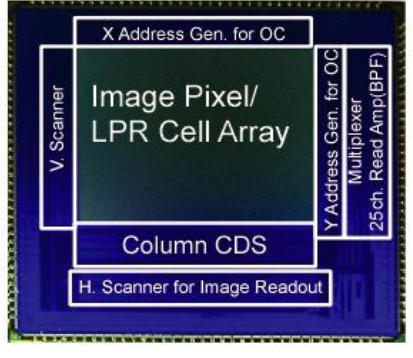
Figure 18. The micrograph of CMOS image sensor chip.